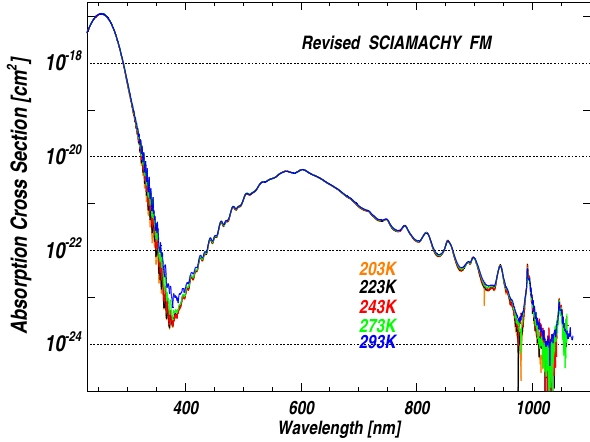
Fig. 2. Spectra of optical density obtained from four measurements in the Huggins band using different ozone concentrations and opti- cal path lengths. Only limited regions of each spectrum are useful, as in most parts saturation is present or the optical density calculated is below the detection limit.